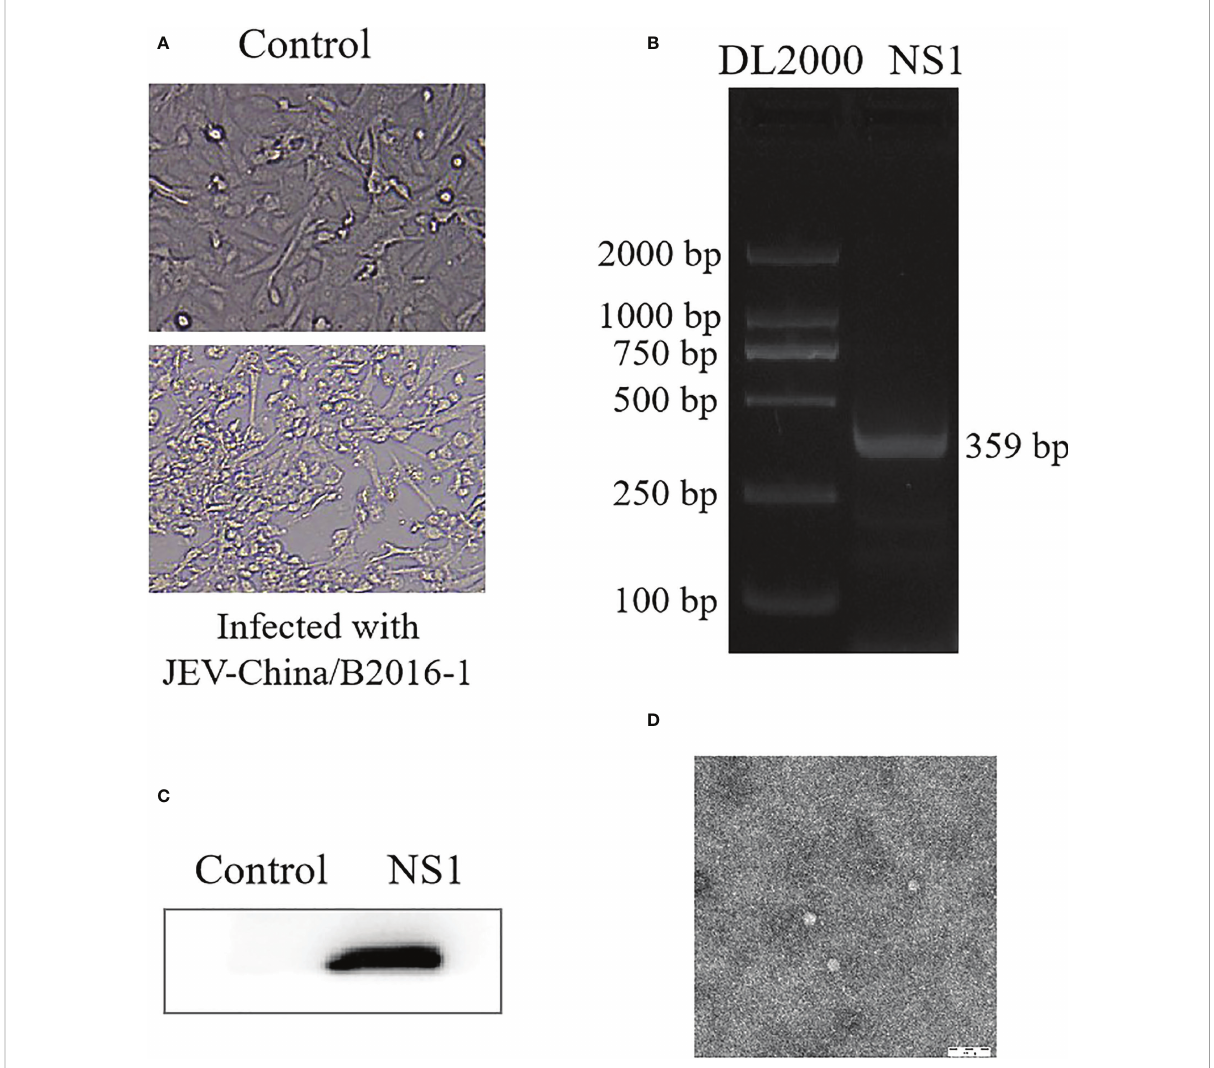
FIGURE 6 Identi fi cation of JEV-China/B2016-1 isolated in Lincang city of Yunnan province. CPE observation of JEV-China/B2016-1 after BHK-21 cells infection (A) . Identi fi cation of JEV-China/B2016-1 by PCR (B) . Veri fi cation of JEV-China/B2016-1 by Western blot (C) . Negative-stain electron microscopy of JEV-China/B2016-1 particles (D)